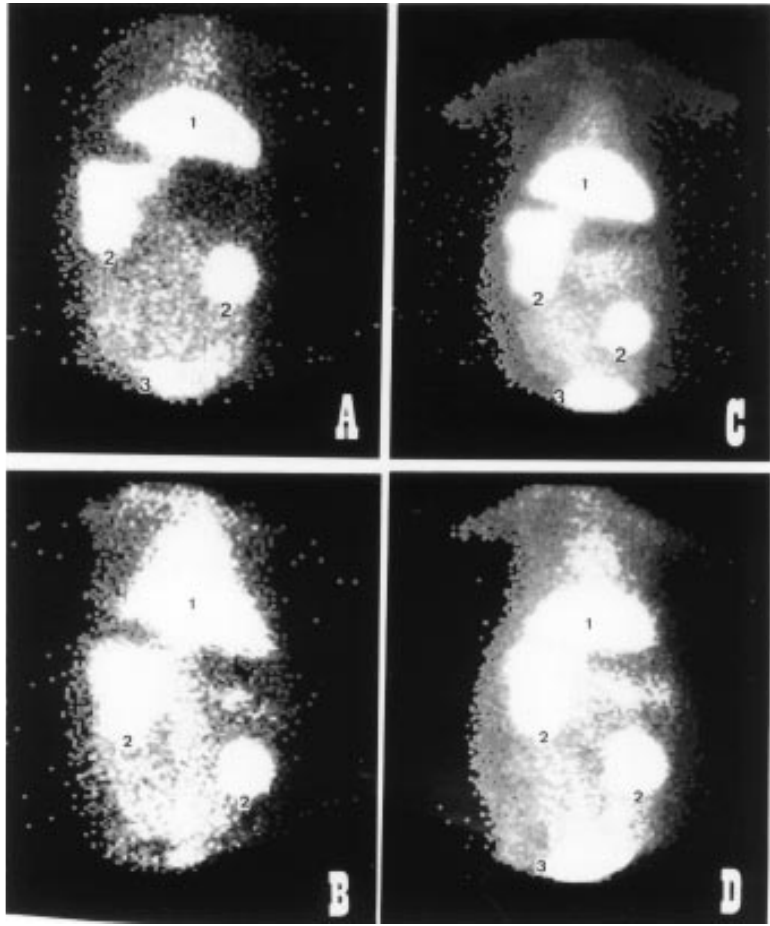
Figure 2 - Biodistribution of 99m Tc-labeled ß-VLDL 6 h after tracer injection. A , 99m Tc-nat-ß- VLDL in a control rabbit; B , 99m Tc-nat-ß-VLDL in a cholesterol-fed rabbit; C , copper-oxidized 99m Tc-ß-VLDL in a control rabbit; D , copper-oxidized 99m Tc-ß-VLDL in a cholesterol-fed rabbit. 1, Liver; 2, kidney; 3, urinary